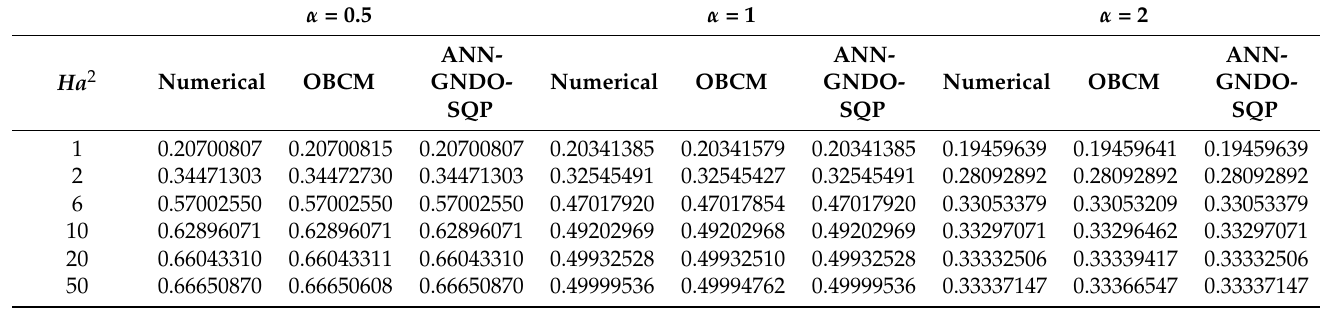
Table 4. Comparison of values obtained by the ANN-GNDO-SQP algorithm for w ∗ ( 0 ) with OBCM [20] and numerical solution for different values of nonlinearity parameter and Hartmann electric number.